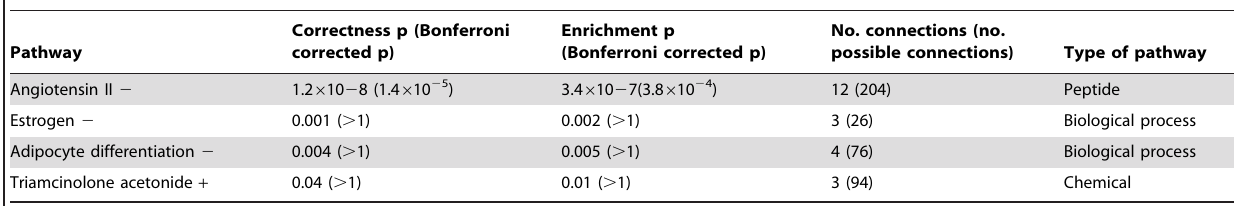
Table 4. Pathways identified by causal